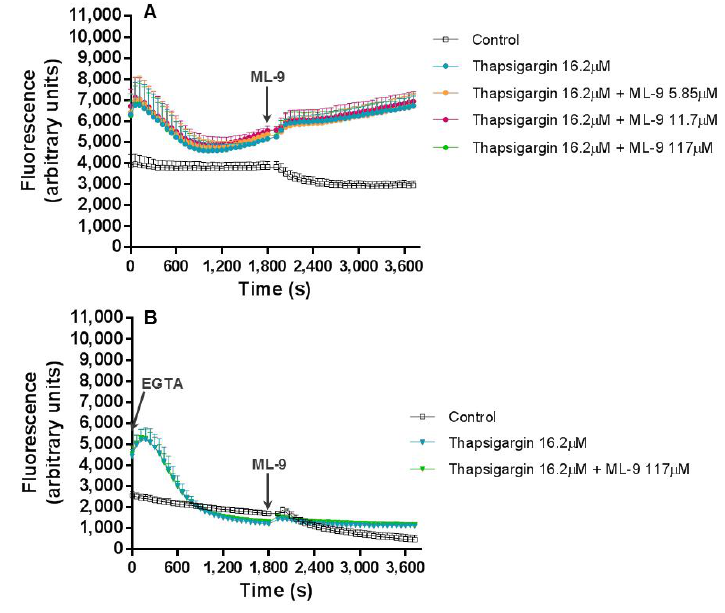
Figure 4. Thapsigargin and ML-9 combined effects. Thapsigargin (16.2 µ M) and ML-9 (0–117 µ M), added 30 min after the beginning of the experiment, combined effects on human neutrophils intracellular Ca 2+ concentration, during 1 h of incubation time, in the absence ( A ) or presence ( B ) of EGTA (800 µ M). The values are given as the mean ± SEM ( n ≥ 3). The ‘control’ assay corresponds to the experimental conditions without thapsigargin and ML-9. The figure represents only the most relevant conditions